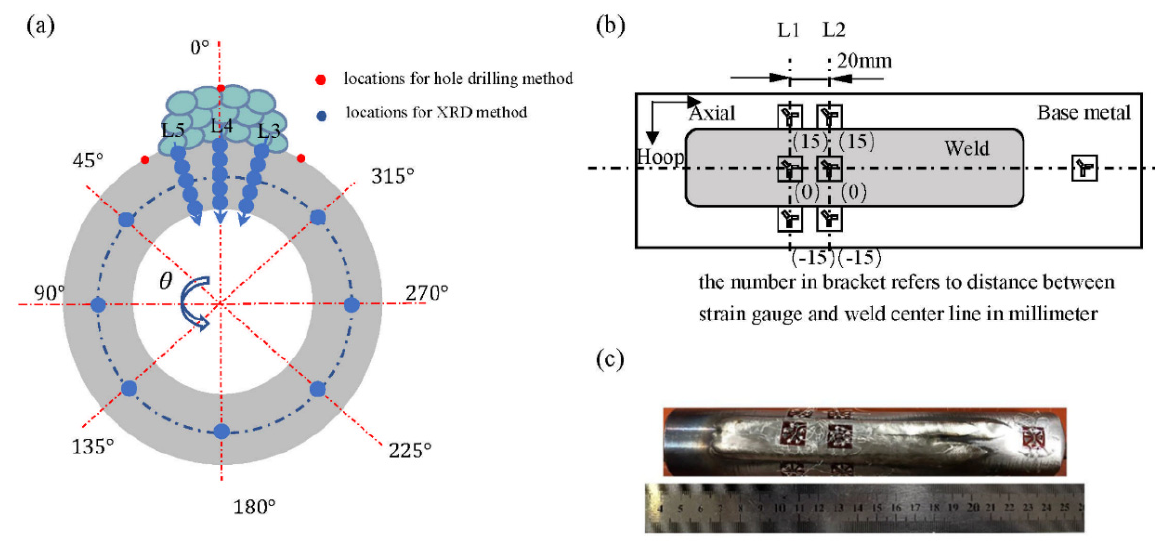
Figure 3. Locations of residual stress measurement: ( a ) locations on the transverse cross section of the overlaying sample, ( b ) schematic diagram of stress measurement locations, and ( c ) experimental locations with hole drilling method. The blind hole method is a simple and effective method for measuring residual stress at a certain depth. It has a standardized operation process and the measurement results are accurate and reliable. The blind hole method measures the residual stress by drilling a small blind hole in the strain center to locally release the residual stress and obtain the released strains in different directions from the strain rosettes to calculate the residual stress. The principal stress calculation equations are as follows: